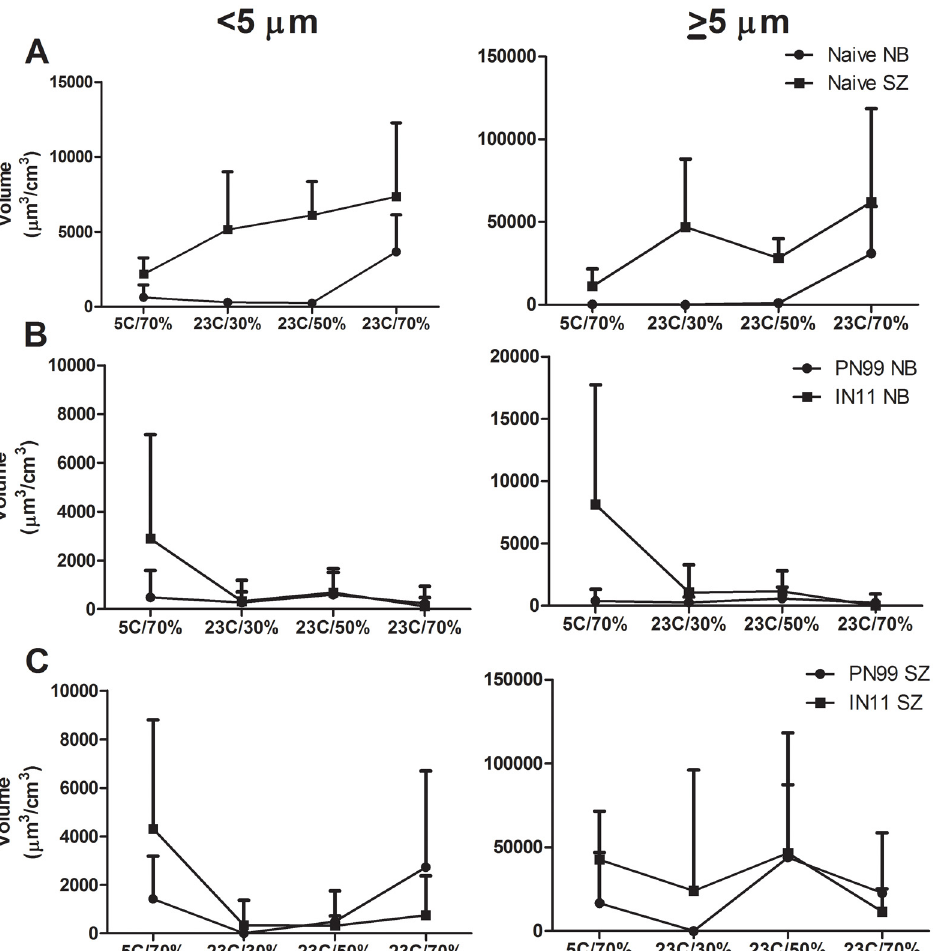
Fig 4. Volume of aerosols exhaled by na ï ve and influenza virus inoculated ferrets. Aerosol volumes were measured from ferrets during 15 minutes of normal breathing (NB) or 5 minutes of sneezing stimulation (SZ). Data collected from na ï ve animals, n = 6 (A), and data collected from inoculated animals (normalized to each ferret ’ s na ï ve level of aerosol shedding), n = 3, on 2, 4 and 6 dpi were combined and compared between PN99 and IN11 virus groups for aerosols < 5 μ m and (cid:3) 5 μ m (B,C). Ferrets were housed under controlled environmental conditions as indicated. Data are presented + standard